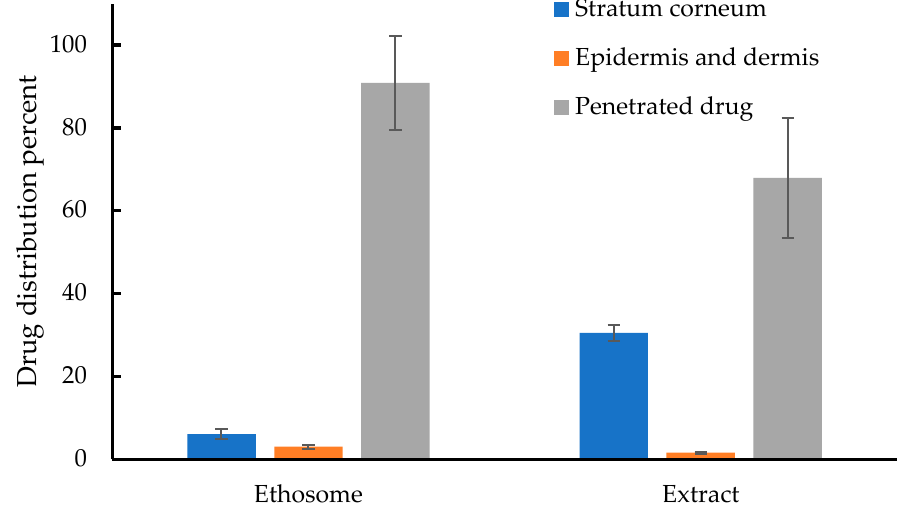
Figure 7. Retained ratio of zerumbone from the in vitro skin retention investigation in various skin layers.